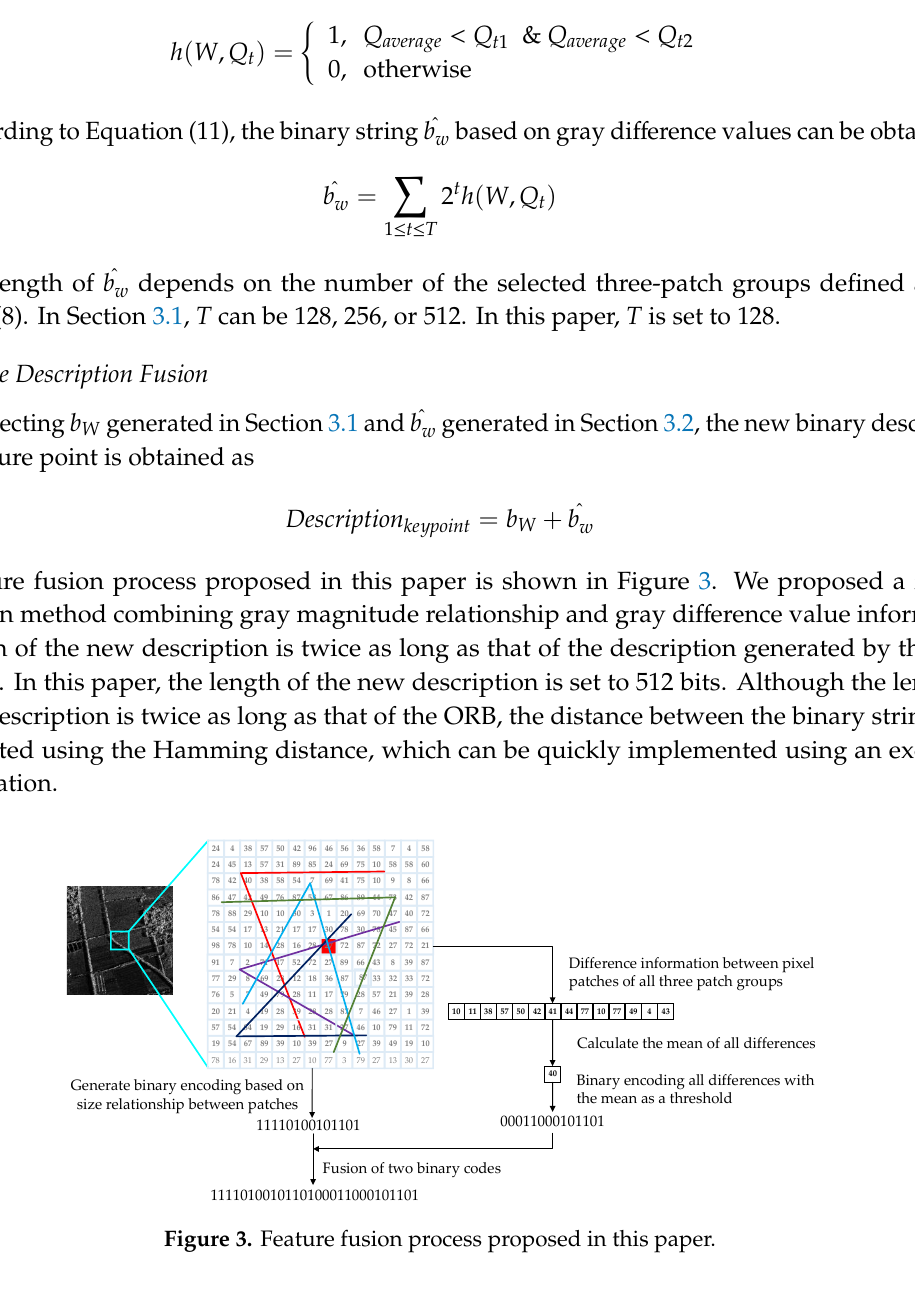
Figure 2. Binary string using gray difference value information.